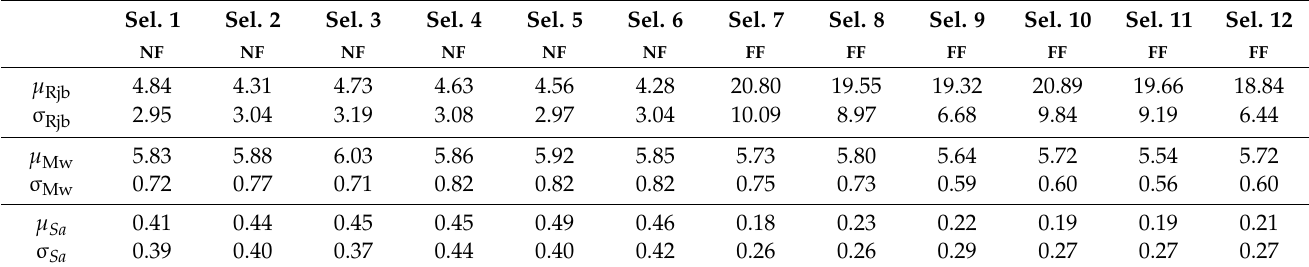
Table 2. Mean and standard deviation of each record selection magnitude, epicentral distance and spectral acceleration normal